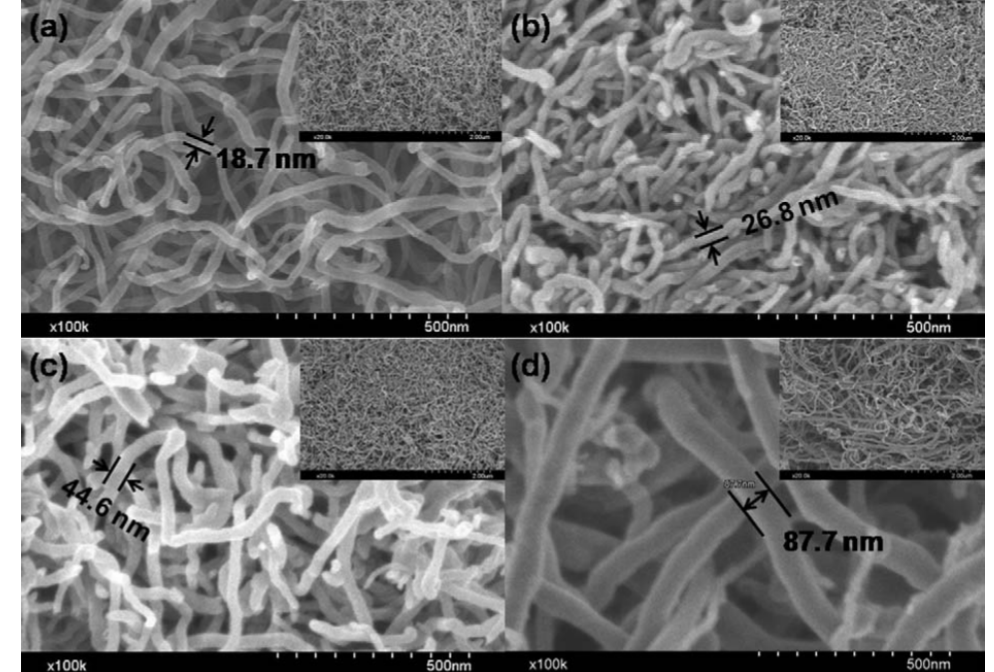
Figure 5. FESEM (Field emission scanning electron microscopy) images of the MWCNTs (multiwalled carbon nanotubes) with diameter range of ( a ) 10–20 nm; ( b ) 20–40 nm; ( c ) 40–60 nm; and ( d ) 60–100 nm. (Reprinted with permission from [58]. Copyright (2012) by